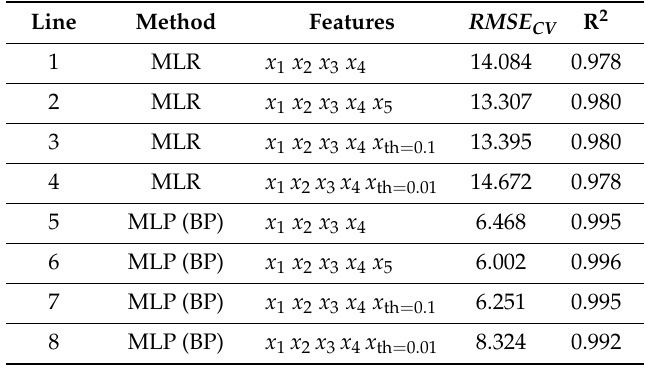
Table 4. Comparison of di ff erent modeling methods. Multivariable linear regression (MLR) and multilayer perceptron